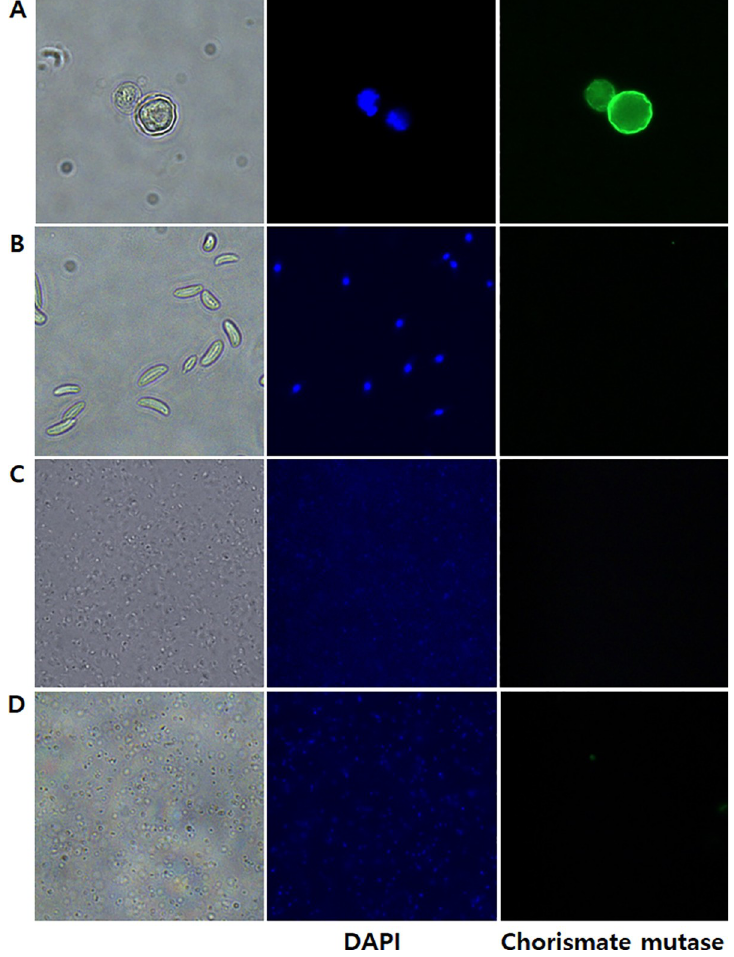
Fig 6. Confirming the species-specificity of the A . castellanii chorismate mutase antibody using immunocytochemistry. A . castellanii cysts (A), F . solani (B), P . aeruginosa (C), and S . aureus (D) were visualized under a fluorescence microscope. Bright-field, DAPI-stained, and indirect immunocytochemical labeling images were acquired at 400x magnification.